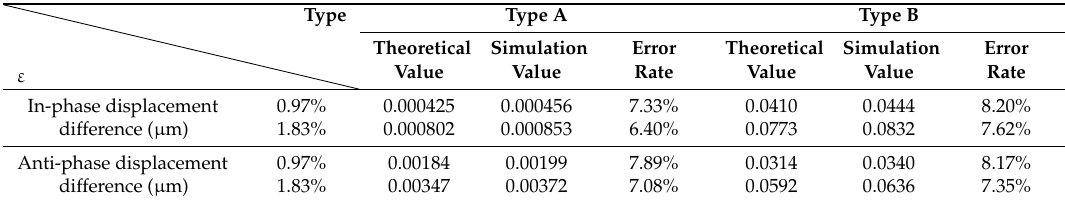
Table 3. Comparisons with theoretical and numerical values of Type A and Type B.